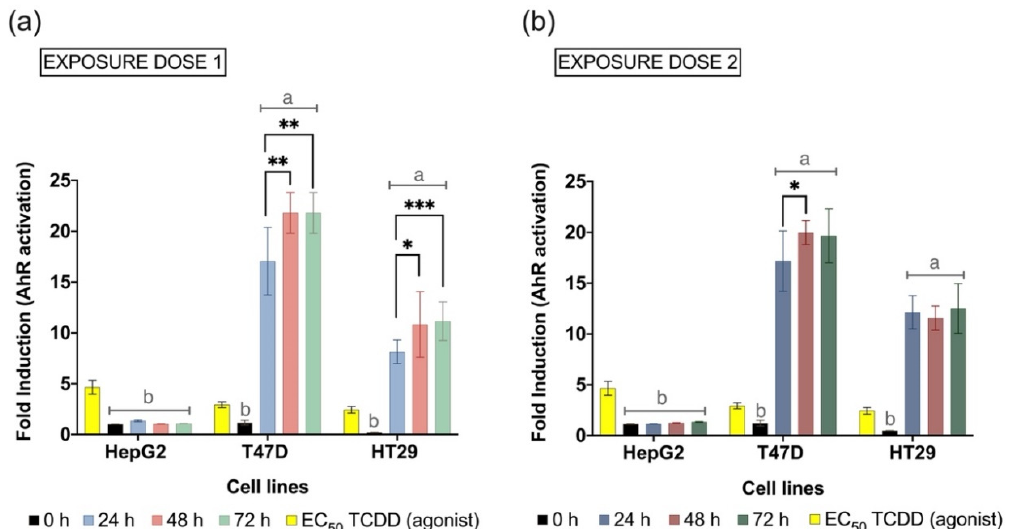
Figure 5. AhR transcriptional activity induced by the metabolic output samples and the agonist control TCDD. The three AhR-reporter gene cell lines (HepG2, T47D, HT29) were exposed in tripli- cate to the samples from the three independent repetitions of the colon simulation (n = 9). Results are expressed as mean fold induction ± SD of luminescence prompted by the exposed cells when compared with untreated cells in the same assay plate. ( a ) Exposure dose 1:20 µ L of sample + 30 µ L of fermentation medium, ( b ) exposure dose 2:50 µ L of sample. Treatments corresponded to filtered, sterilized supernatant harvest from the colonic fermentation at the inoculation day (0 h) and after 24 h, 48 h, and 72 h. Differences between treatment in each cell line were compared, and statistical significance is indicated as p < 0.05 (*), p < 0.01 (**), and p < 0.001 (***). Lowercase letters repre- sent differences in AhR induction as compared with the EC 50 of TCDD in the respective cell line, a: significantly greater than TCDD p < 0.001, and b: effects significantly lower than TCDD p <